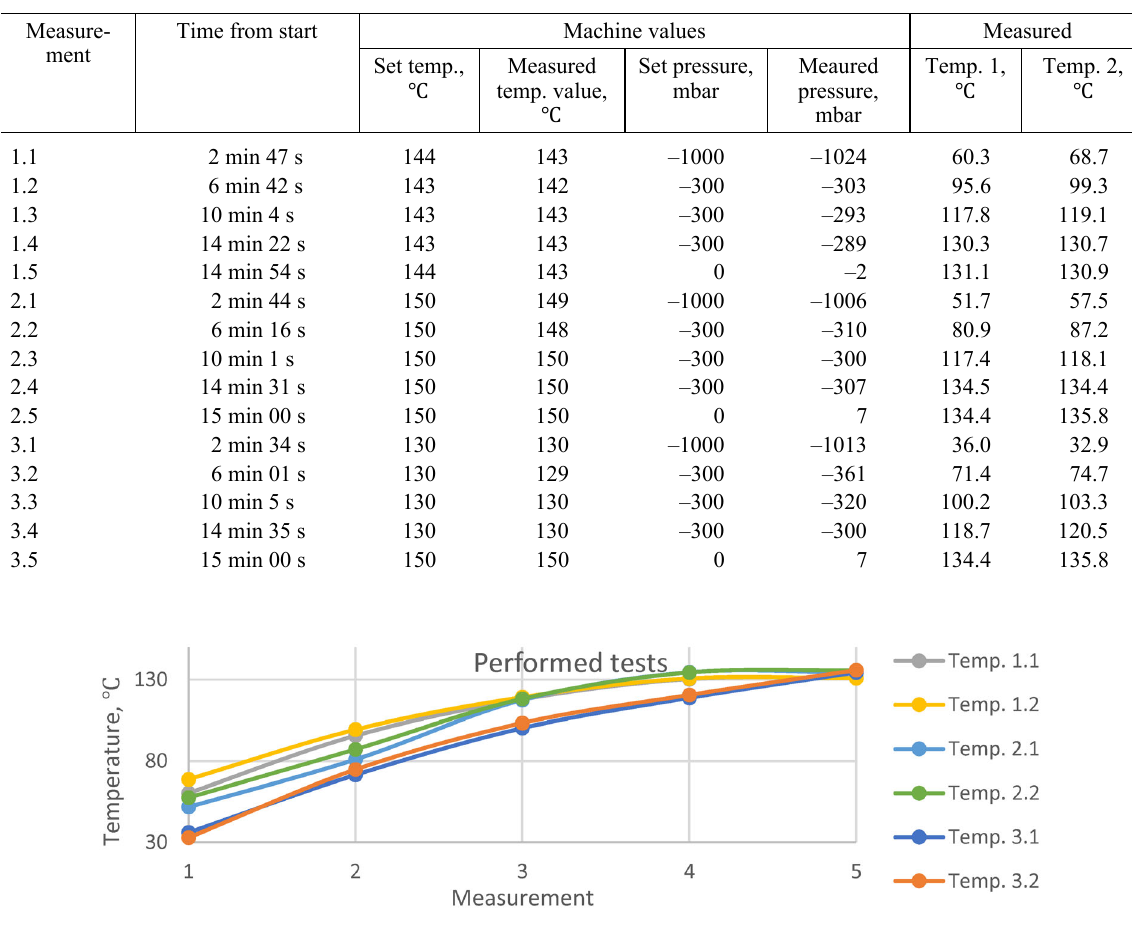
Fig. 4. Temperature test results in different positions and input